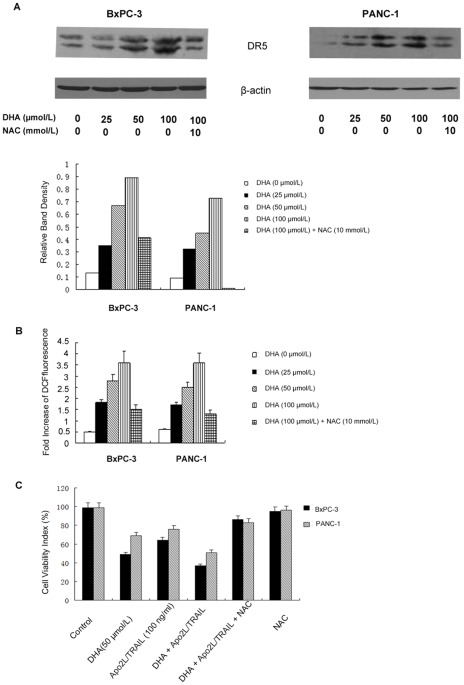
Up-regulation of DR5 by DHA was mediated by ROS.(A) BxPC-3 and PANC-1 cells were treated with the indicated doses of DHA for 48 h. Whole cell extracts were prepared and analyzed for DR5 expression using western blotting. DHA had dose-dependent effects on the expression of DR5. The DHA-induced increase in DR5 levels was significantly blocked by pretreatment with 10 mM NAC. β-actin served as an internal control. (B) The cells were collected and analyzed using flow cytometry. A gradual increase in fluorescence was observed in cells treated with 25, 50 and 100 µmol/L DHA, respectively, indicating a dose-dependent increase in the production of ROS in response to DHA treatment in the two cell lines. The production of ROS was markedly inhibited by pretreating the cells with NAC (10 mM). (C) The cells were treated with DHA (50 µmol/L) alone, Apo2L/TRAIL (100 ng/ml) alone or a combination of the two agents. The cells were also treated with NAC (10 mM) alone or pretreated with NAC and incubated at 37°C for 72 h. The viability of the cells was assessed using the MTT method and the viability index (%) was calculated. Significant differences are denoted by “*” (P<0.01).